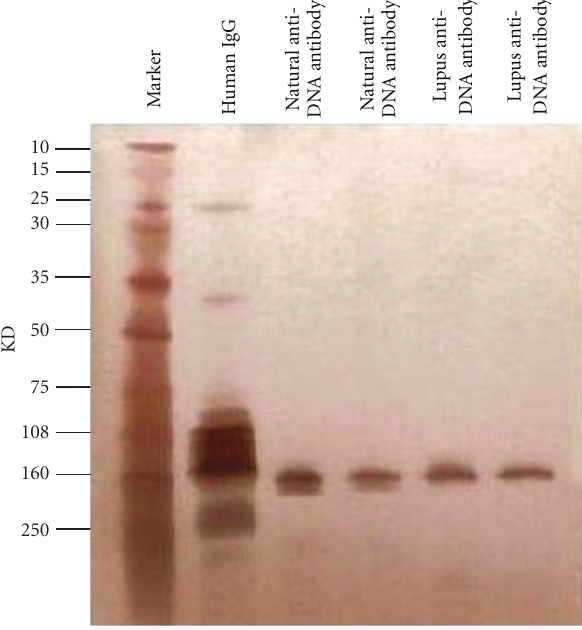
Figure 2: Classification of isolated anti-DNA antibody by western blot. ∗ Western blotting was used to confirm that the proteins iso- lated using the two-step purification method are